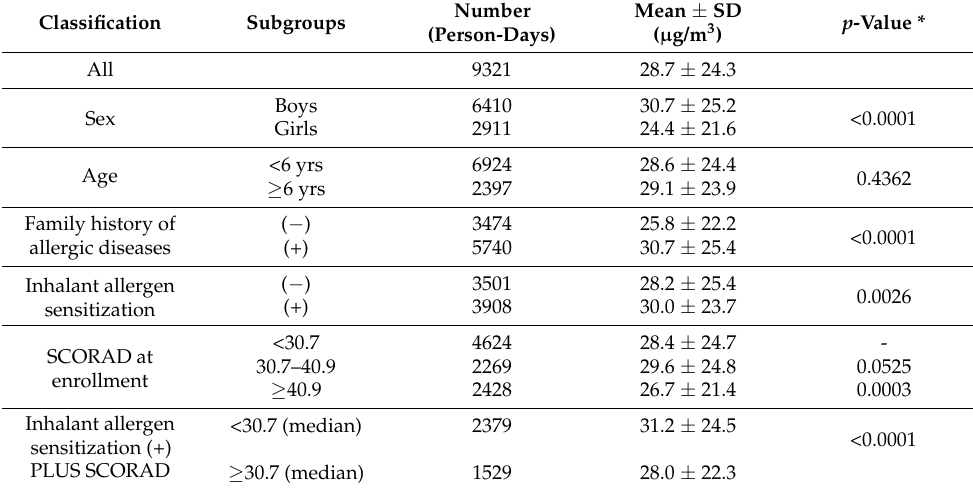
Table 3. Summary of indoor PM 2.5 concentration by subgroup ( n =